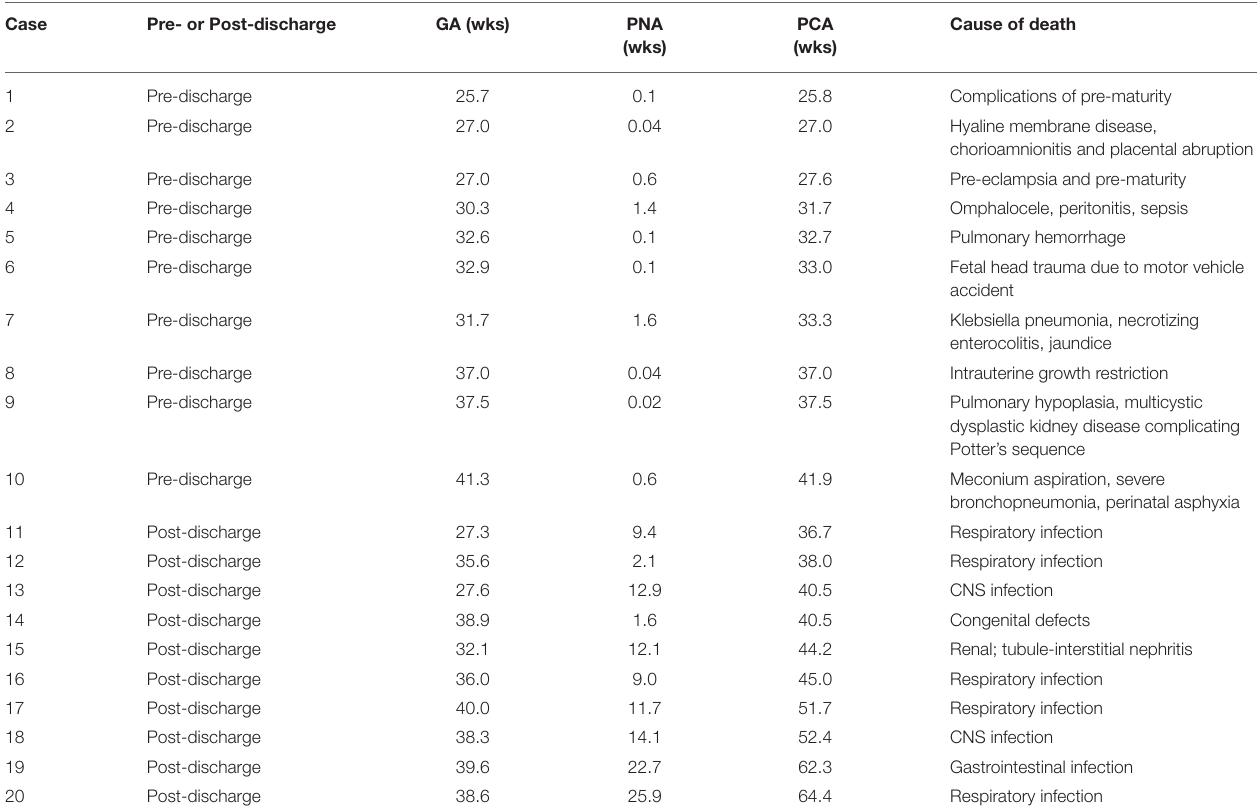
TABLE 1 | Causes of death in pre- and post-discharge known cause of death (KCOD)